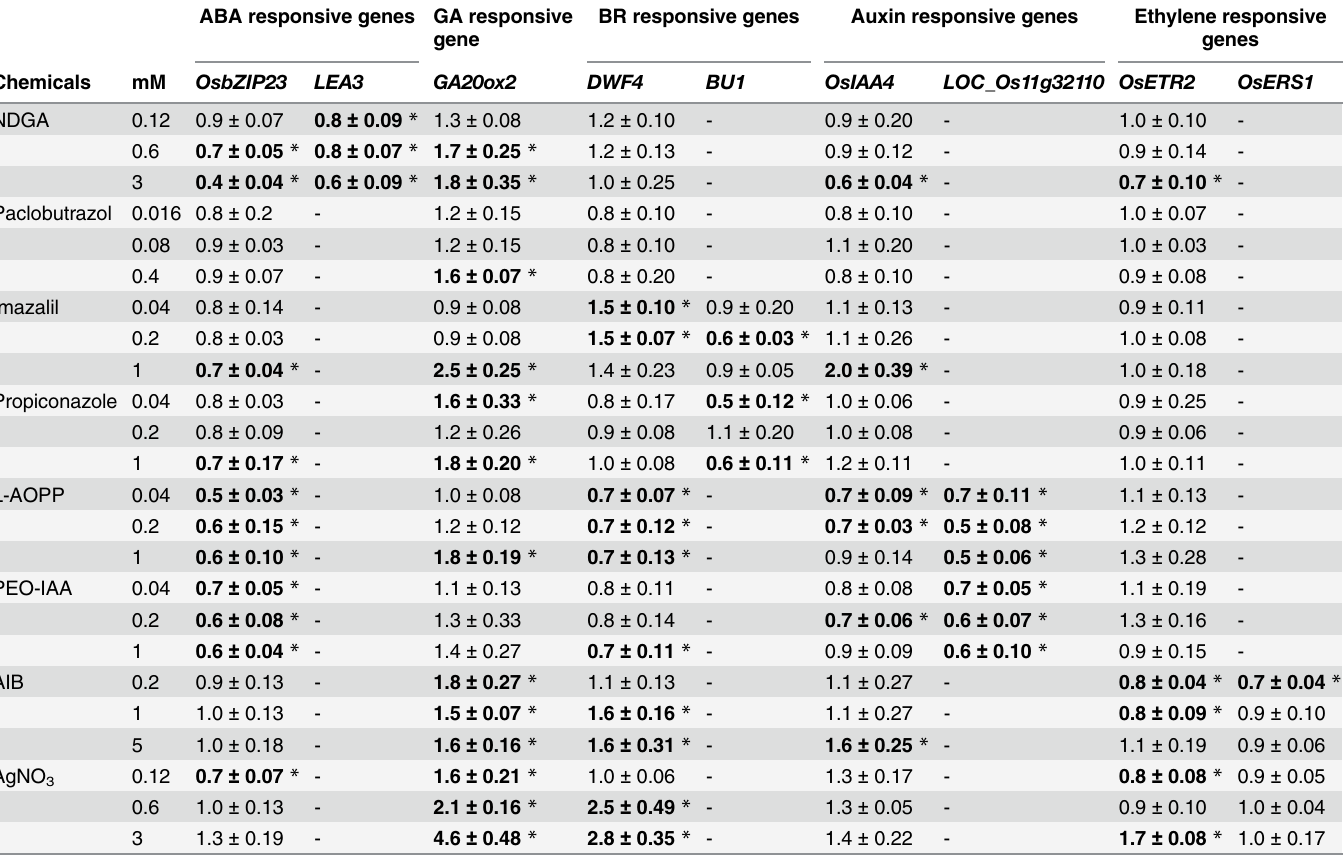
Table 3. Changes in the relative expression of rice hormone-responsive genes after inhibitor